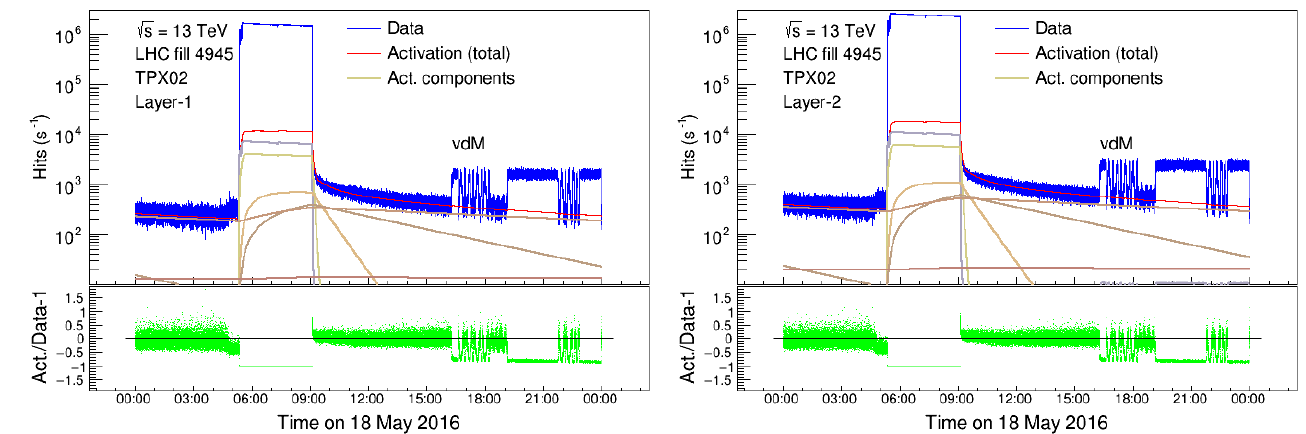
Figure 46. Hit rate measured with TPX02 layers 1 and 2 before and after the vdM scan on 18 May 2016 as a function of time. Each data point shows the count rate of a 1s frame. Initially, a small background rate is observed. Then, at about 5:00, high-intensity LHC proton beams are filled in the accelerator and a small increase in count rate is observed. Subsequently, high-intensity proton collisions take place with count rate above 10 6 s − 1 . After the high-intensity proton collisions, the falling activation curve is clearly recognizable. The vdM scan with low-intensity LHC proton beams starts around 16:00. The figure shows also the determined total activation rate and six components with different life times. During the high-intensity collisions, the activation contribution to the total count rate is at the percent level. The ratio of determined activation and data rates minus one is well centered around zero for the time periods between the proton–proton collisions, indicating a good description of the activation count rate. LHC vdM fill 4945. Taken from Ref. [15].